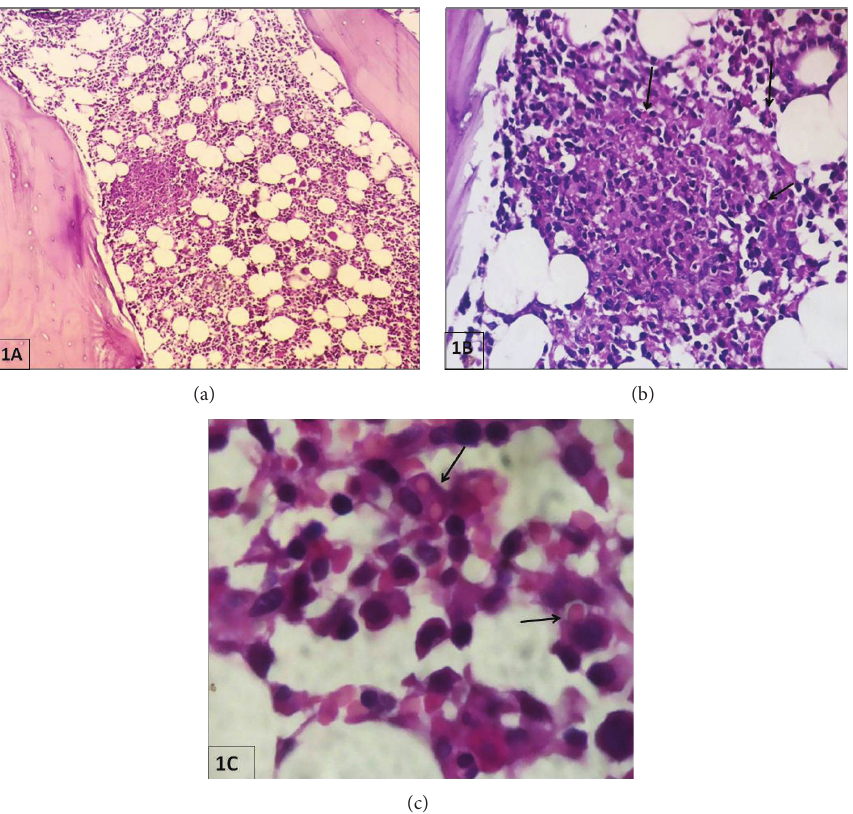
Figure 1: Paraffin embedded decalcified bone marrow trephine biopsy sections from the present case with culture proven typhoid fever which showed epithelioid and histiocytic granulomas in the interstitial and paratrabecular loci. Note the presence of erythrophagocytosis by benign histiocytes (black arrow) in the granulomas (Hematoxylin eosin stain: 100x (a), 400x (b), and 1000x